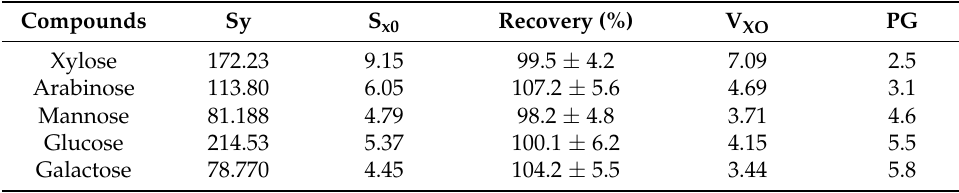
Table 9. Linearity, limit of detection (LOD), limit of quantification (LOQ), correlation coefficient (R 2 ), and reproducibility of sugars. Table 10. Statistical parameters of the calibration